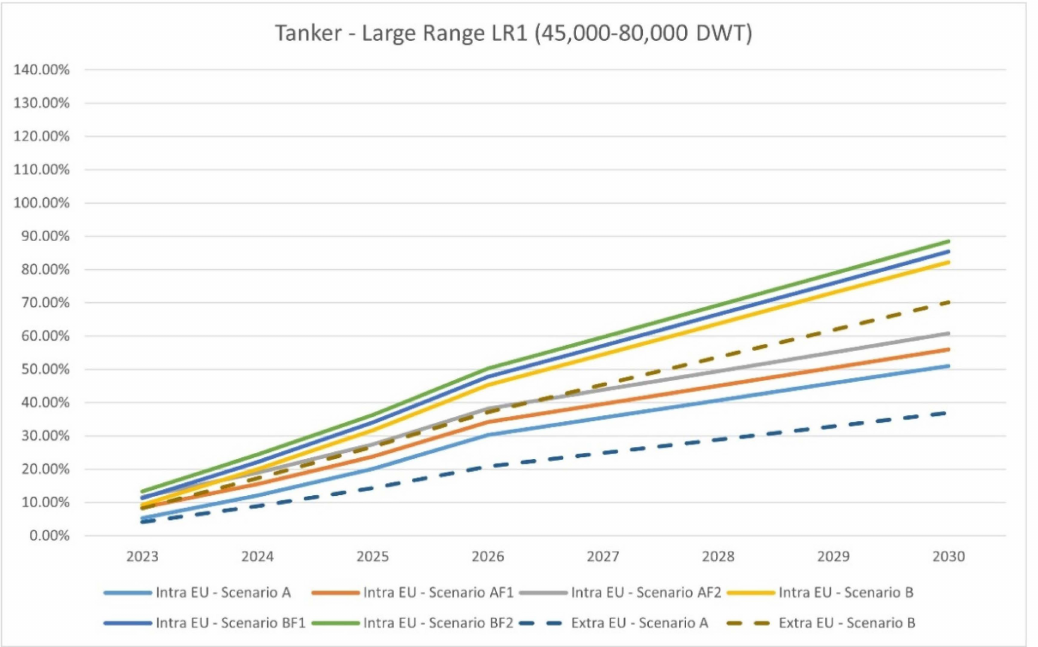
Figure 7. Effect of different scenarios on the OPEX of Large Range 1 tankers; LR1 (45,000–80,000